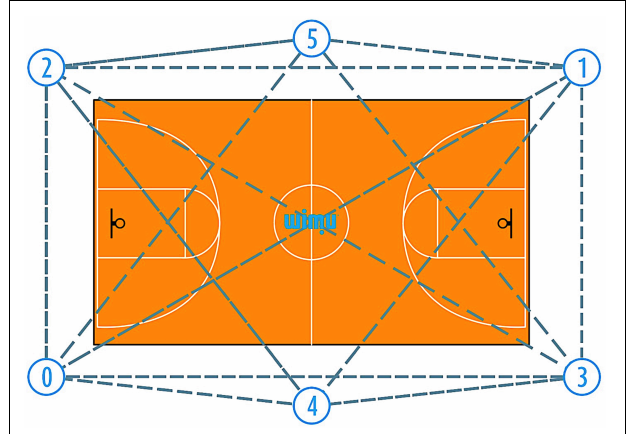
FIGURE 2 | Ultra-Wide Band Antennae court